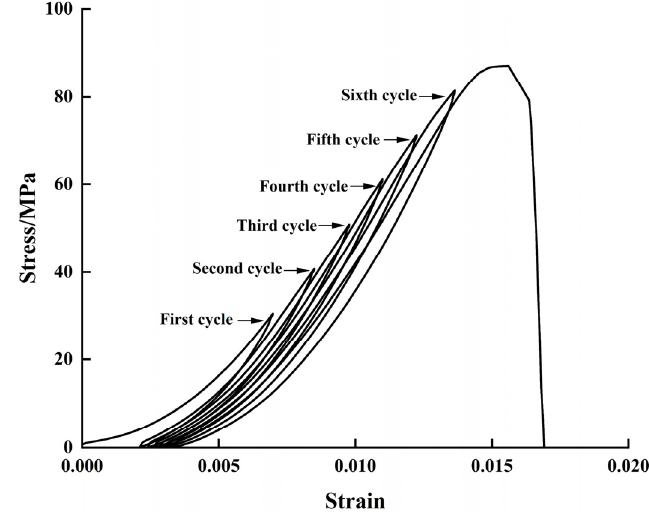
Figure 4. Sandstone cyclic loading test curve.